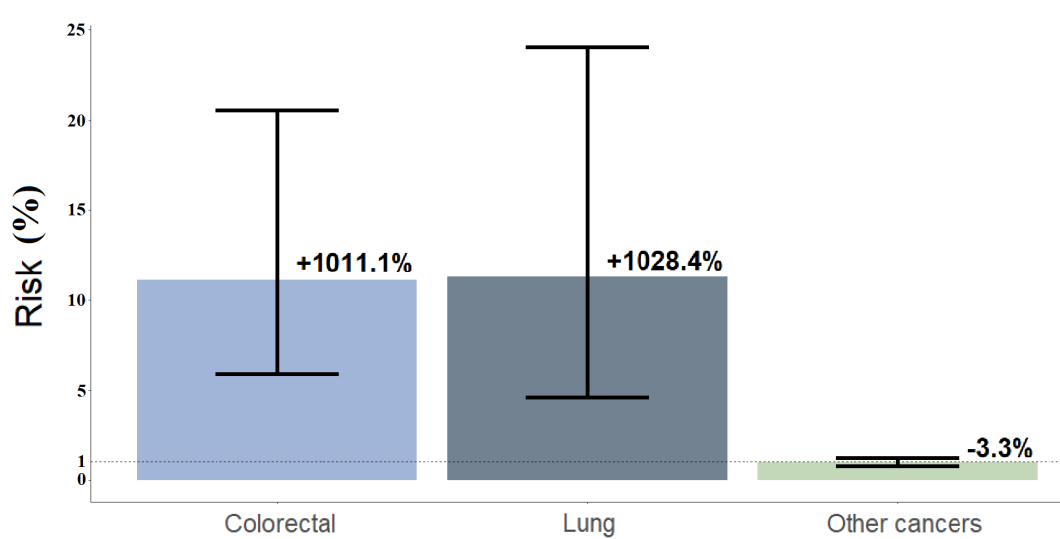
Figure 6. Simulation 3 refers to simulated odds ratios (SORs); percentages are labeled. It was performed for young individuals ( ≤ 55 years old) with bone metastases: male vs. female SORs. Young male patients had a significantly higher risk to receive multiple remote consultations when affected by lung cancer (SOR = 11.30, 95%CI = 4.60, 24.10) and colorectal cancer (SOR = 11.1, 95%CI = 5.90, 20.60). No statistical significance was found for other cancers (SOR = 0.97, 95%CI = 0.76, 1.23). Condition 4: An overall higher risk of having multiple telemedicine visits was found for young cancer patients than for male cancer patients, with SORs of +88.9% (95%CI = +16%, +182%) for lung cancer; +70.1% (95%CI = +24.1%, +143.3%) for colorectal cancer; and +16.5% (95%CI = − 0.9%, +51.9%) for other cancers. Compared with older patients, for young female breast cancer patients, no significant risk was found (+19.5%, 95%CI = − 20%, +65.2%) (Figure